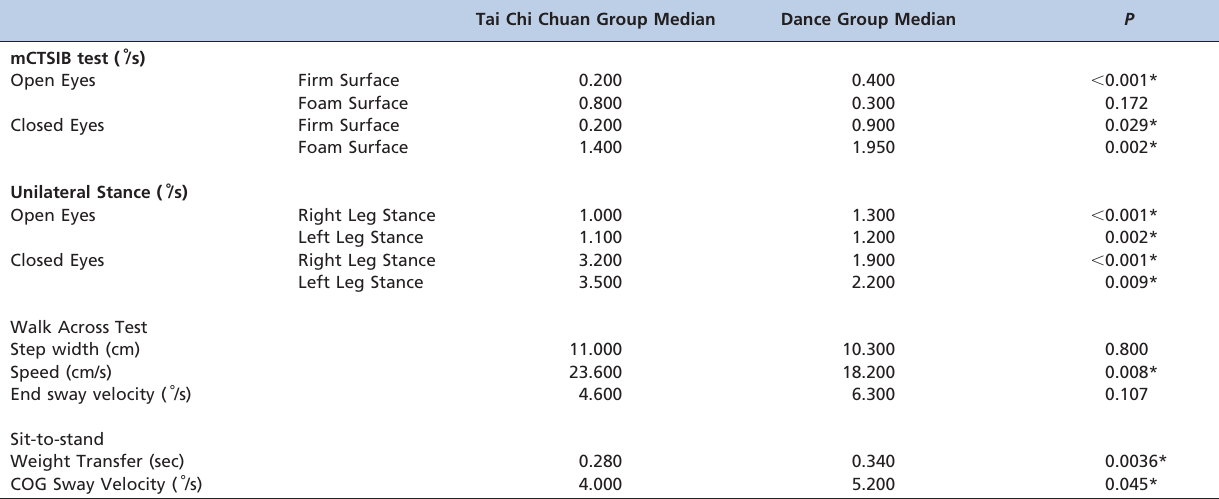
Table 3 - Comparison between the Tai Chi Chuan Group and Dance